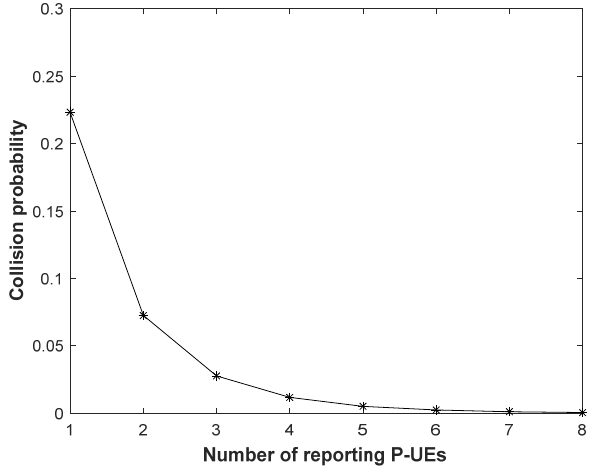
Figure 9. Throughput and overhead of the modified proposed method.